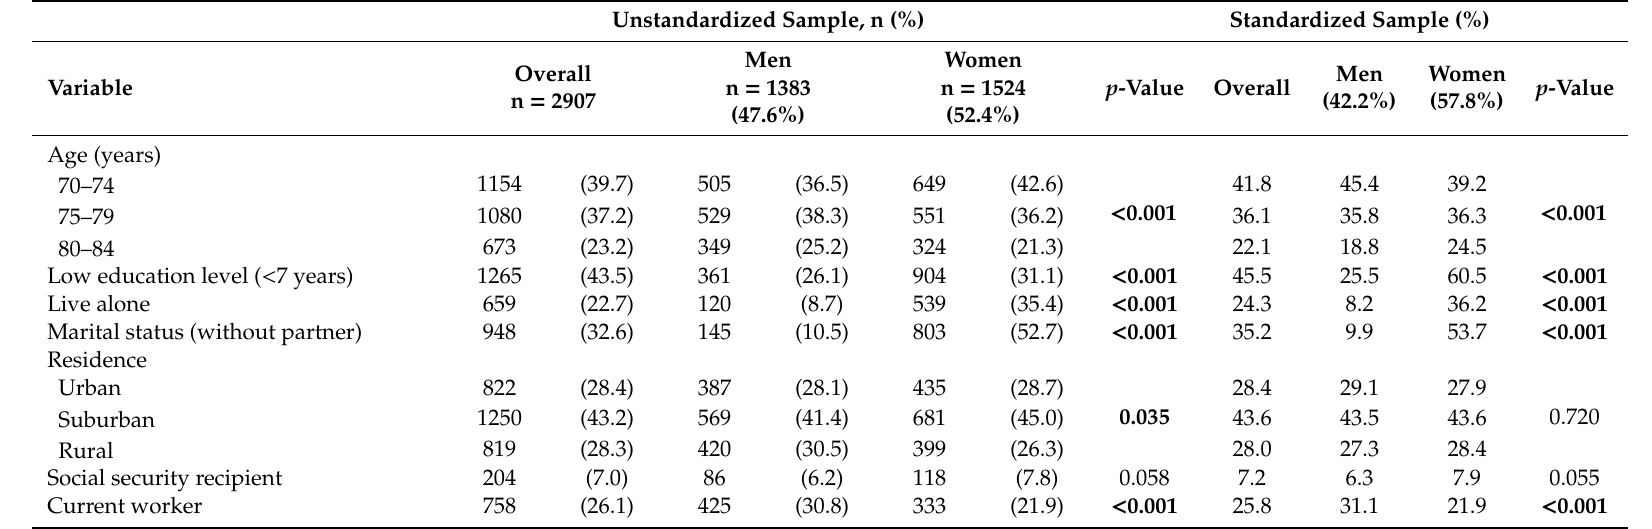
Table 1. Sociodemographic characteristics of the unstandardized and standardized study